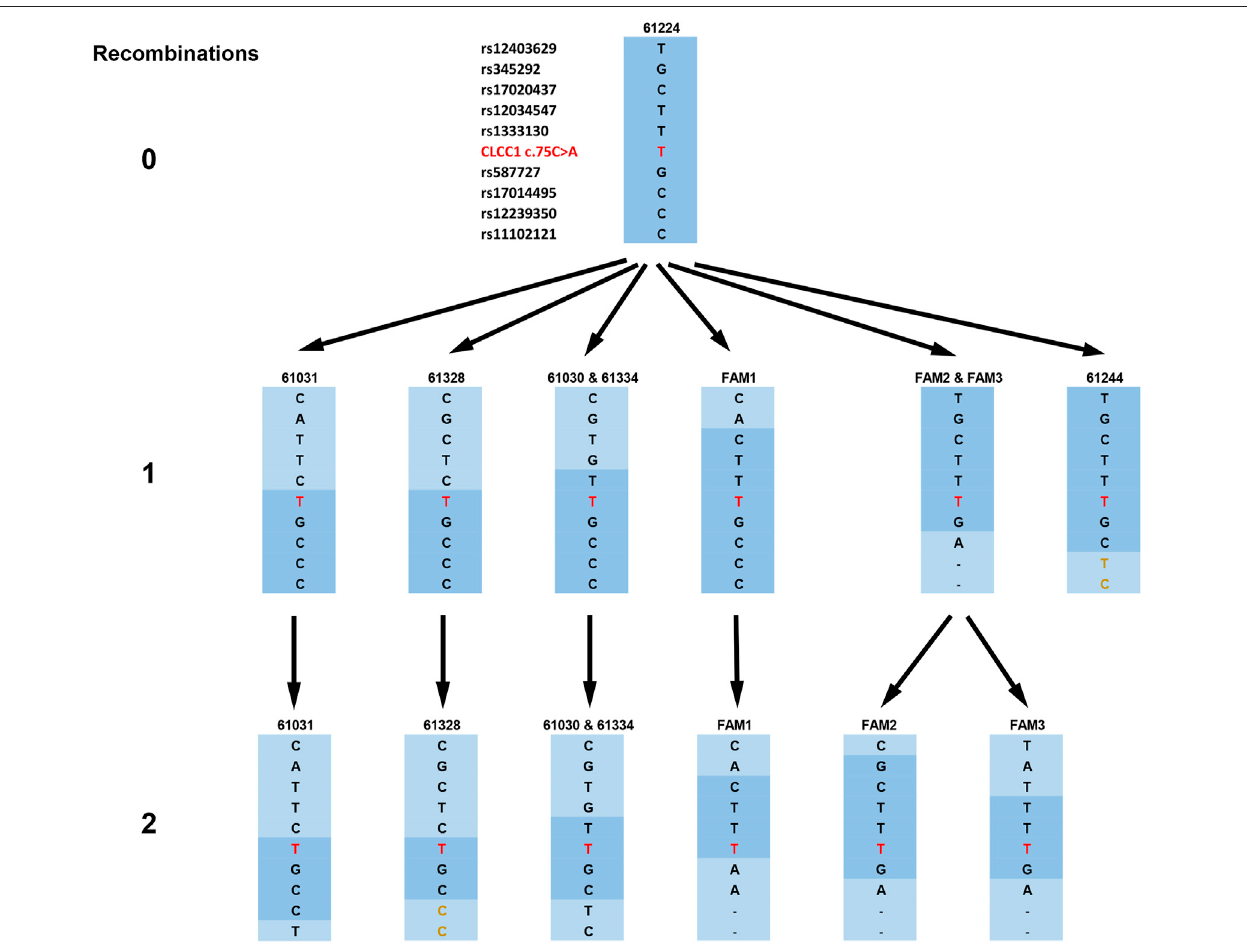
FIGURE 2 | Haplotypes of the families and their derivation from the original risk haplotype, as shown by the compressed haplotype blocks labeled by the fi rst SNP from the c.75C > A mutation (here shown in the fi gure as NC_000001.11:g. 108950376G > T for consistency with other SNPs). The original risk haplotype is shown in dark blue, and recombined haplotype blocks are shown in light blue. The mutation is shown in red and haplotypes in families 61328 and 61244 with the identical initial allele but part of a haplotype differing from those families 61224 (the founder haplotype) and 61030/61334 respectively are shown in gold.